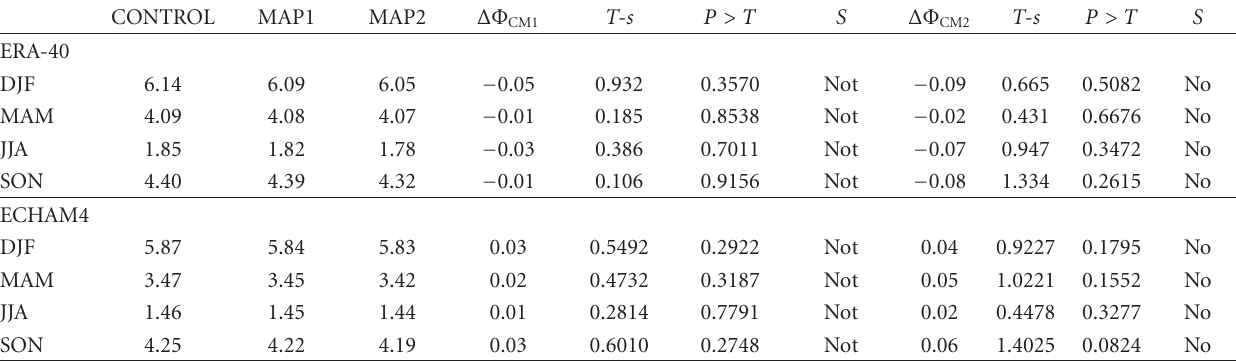
Table 1: Consequences of deforestation/land-use change on the seasonal mean precipitation (mmday − 1 ) averaged over the model domain. ff erence CONTROL map minus MAP1 map. Similarly, ΔΦ ff erence CONTROL map minus MAP2 ΔΦ CM1 corresponds to the di CM2 is the di map. T-s is the Student’s t -test, and P > T is the probability of occurrence. S denotes the significance, if “yes”, the di ff erences are significant, if “no”, then the di ff erences are not significant. Upper half corresponds to ERA40 runs and the lower half to